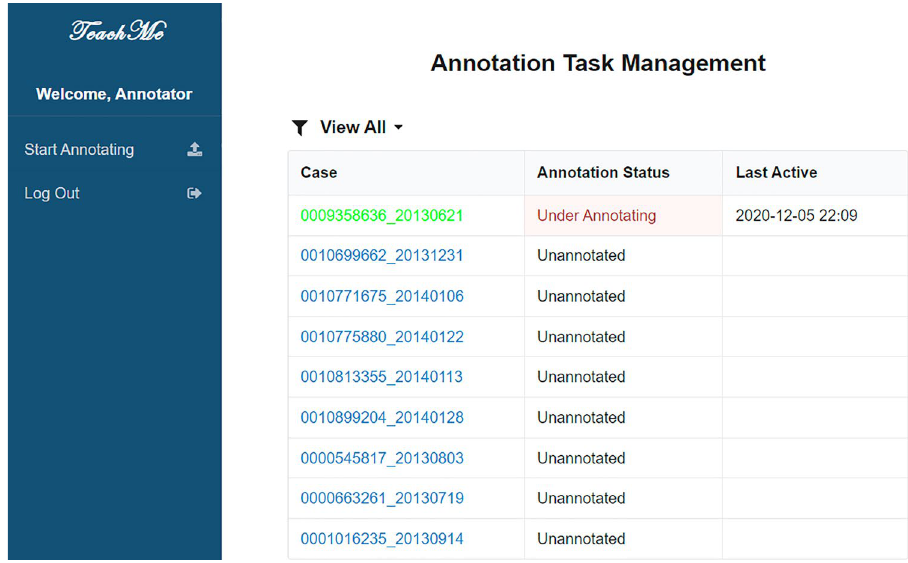
Figure 4. The annotating tasks management